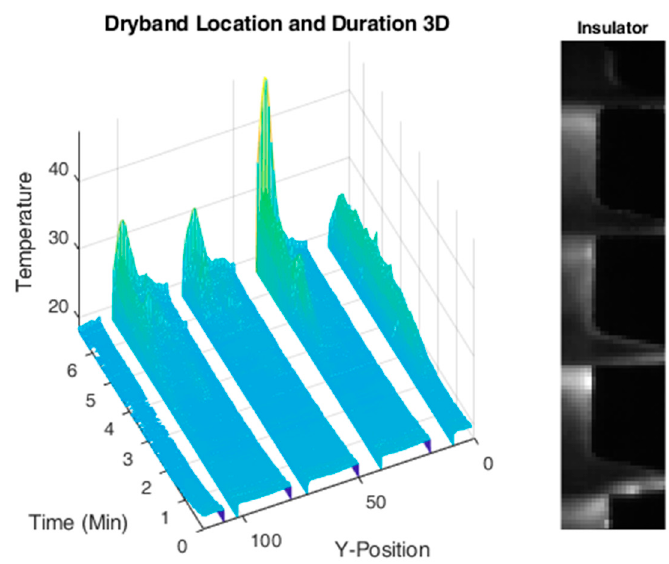
Figure A3. Total dry-band length. Ramp-test: Design CONV, ESDD = 0.42 mg/cm 2 , and a fog rate of 3 L/hr.